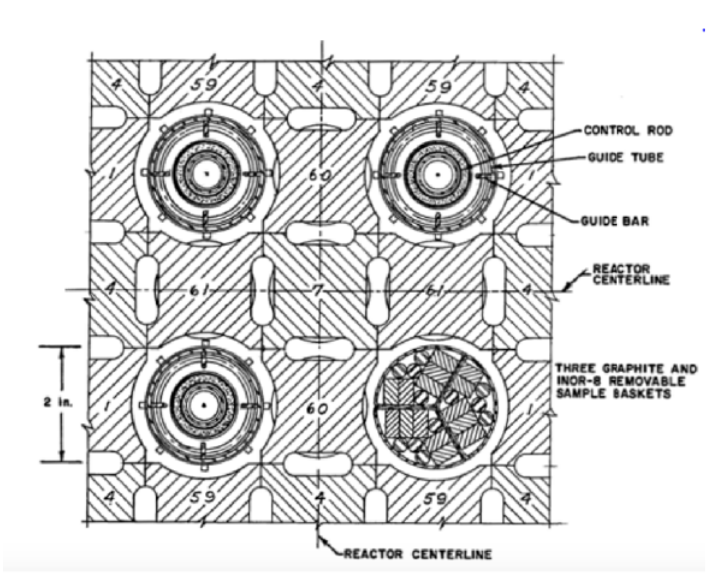
Figure 2: Control rod & sample basket structure